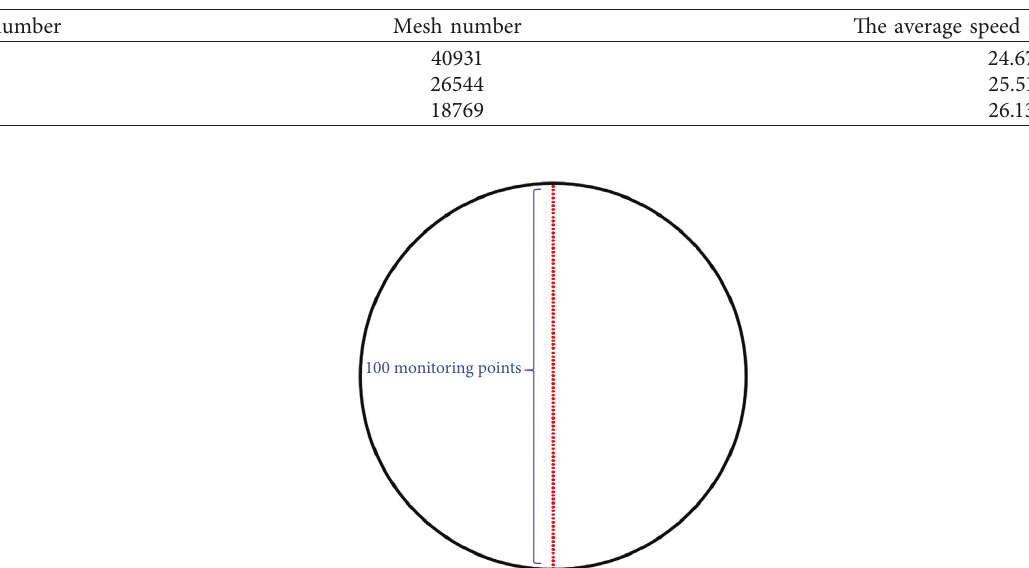
Table 1: Grid independence validation.